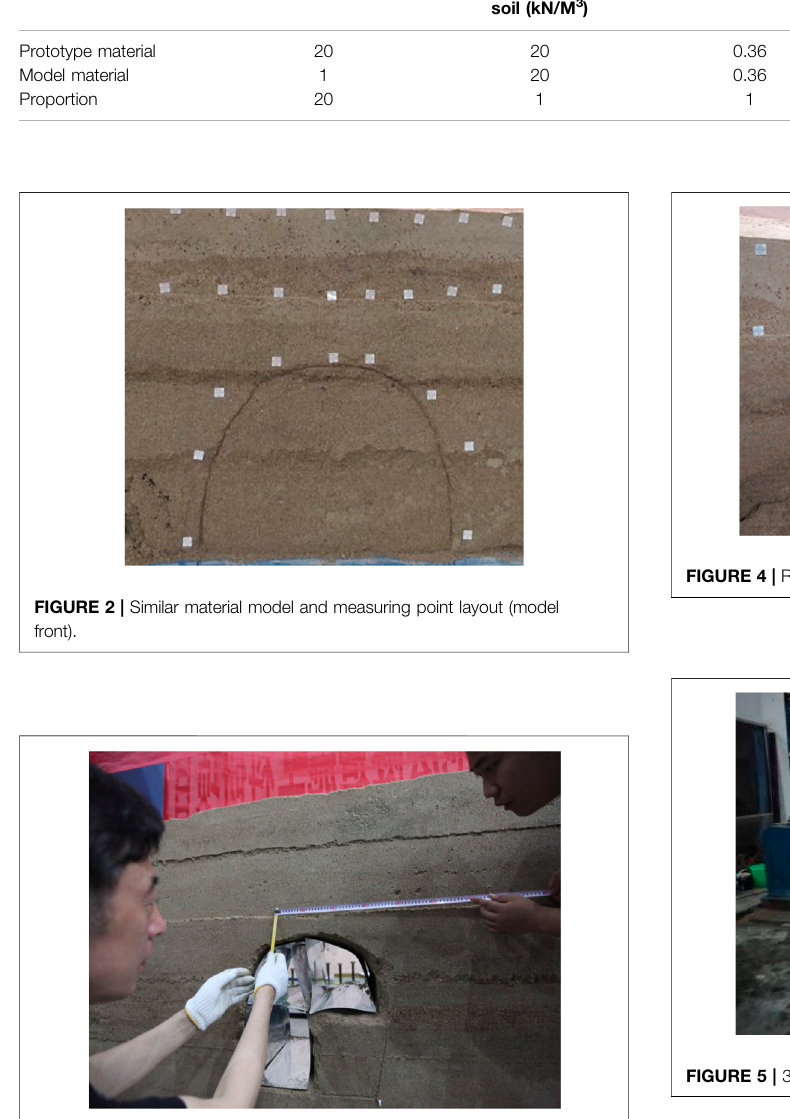
FIGURE 3 | Cracking drawing of the tunnel arch (model back).